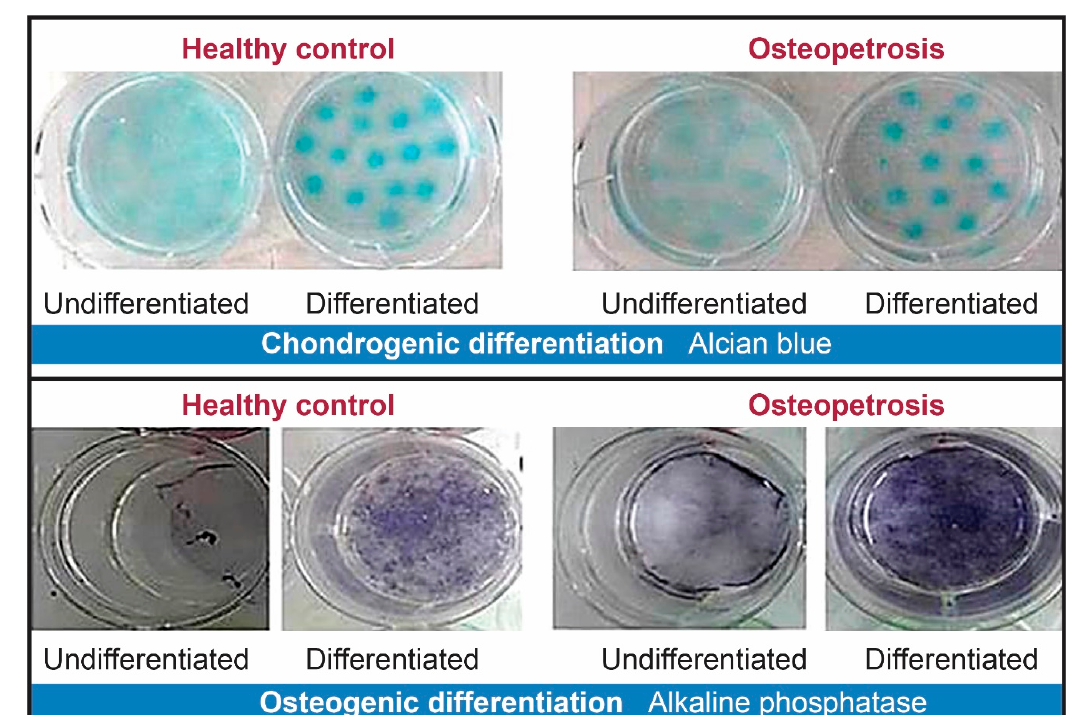
Figure 5. DP-MSC cell differentiation. Upper panel: Chondrogenic differentiation of unsorted bulk DP-MSSCs. Alcian blue staining of undifferentiated and osteogenic differentiated cells in HC and OP subjects after the induction of cells to undergo osteogenic lineage differentiation for 21 days. Lower panel: Osteogenic differentiation of bulk unsorted DP-MSSCs with alkaline phosphatase staining of undifferentiated and osteogenic differentiated cells from HC and OP subjects after induction of cells to undergo osteogenic lineage differentiation for 21 days.